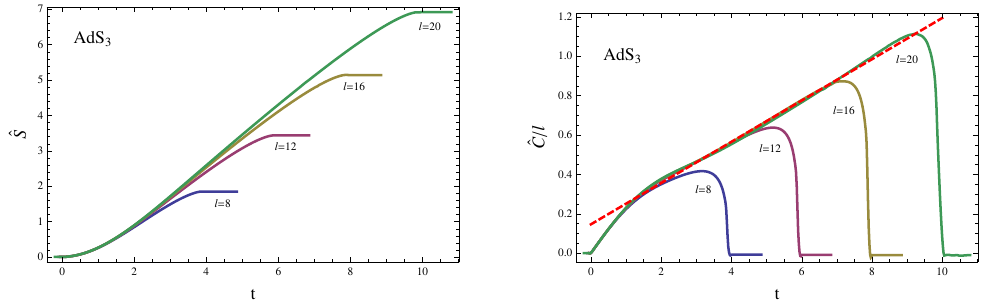
Figure 10 . The evolution of the entanglement entropy and the subregion complexity for di(cid:11)erent l in AdS 3 . We (cid:12)x M = 1 ; v 0 = 0 : 01